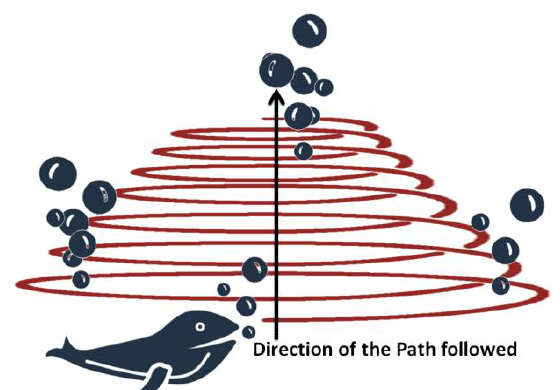
Figure 3(b). Whale Optimized Algorithm inspired by